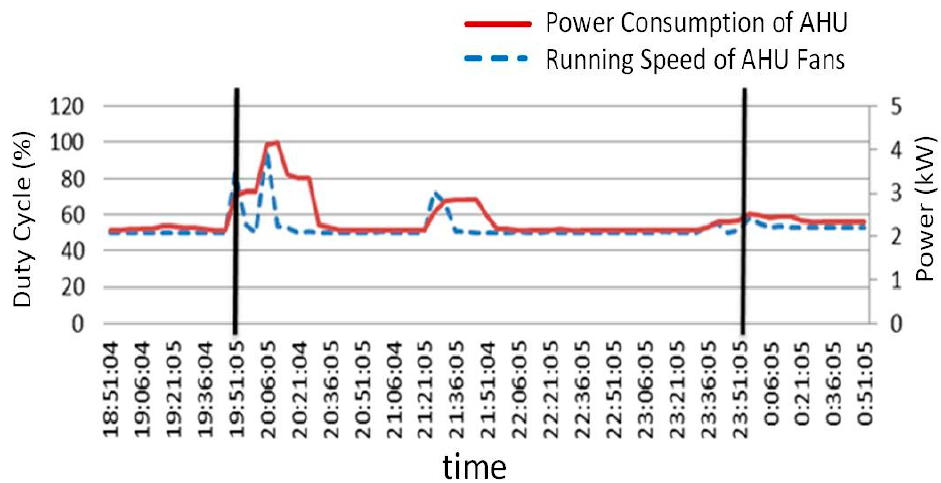
Figure 9. Running speed of AHU fans and AHU power consumption.